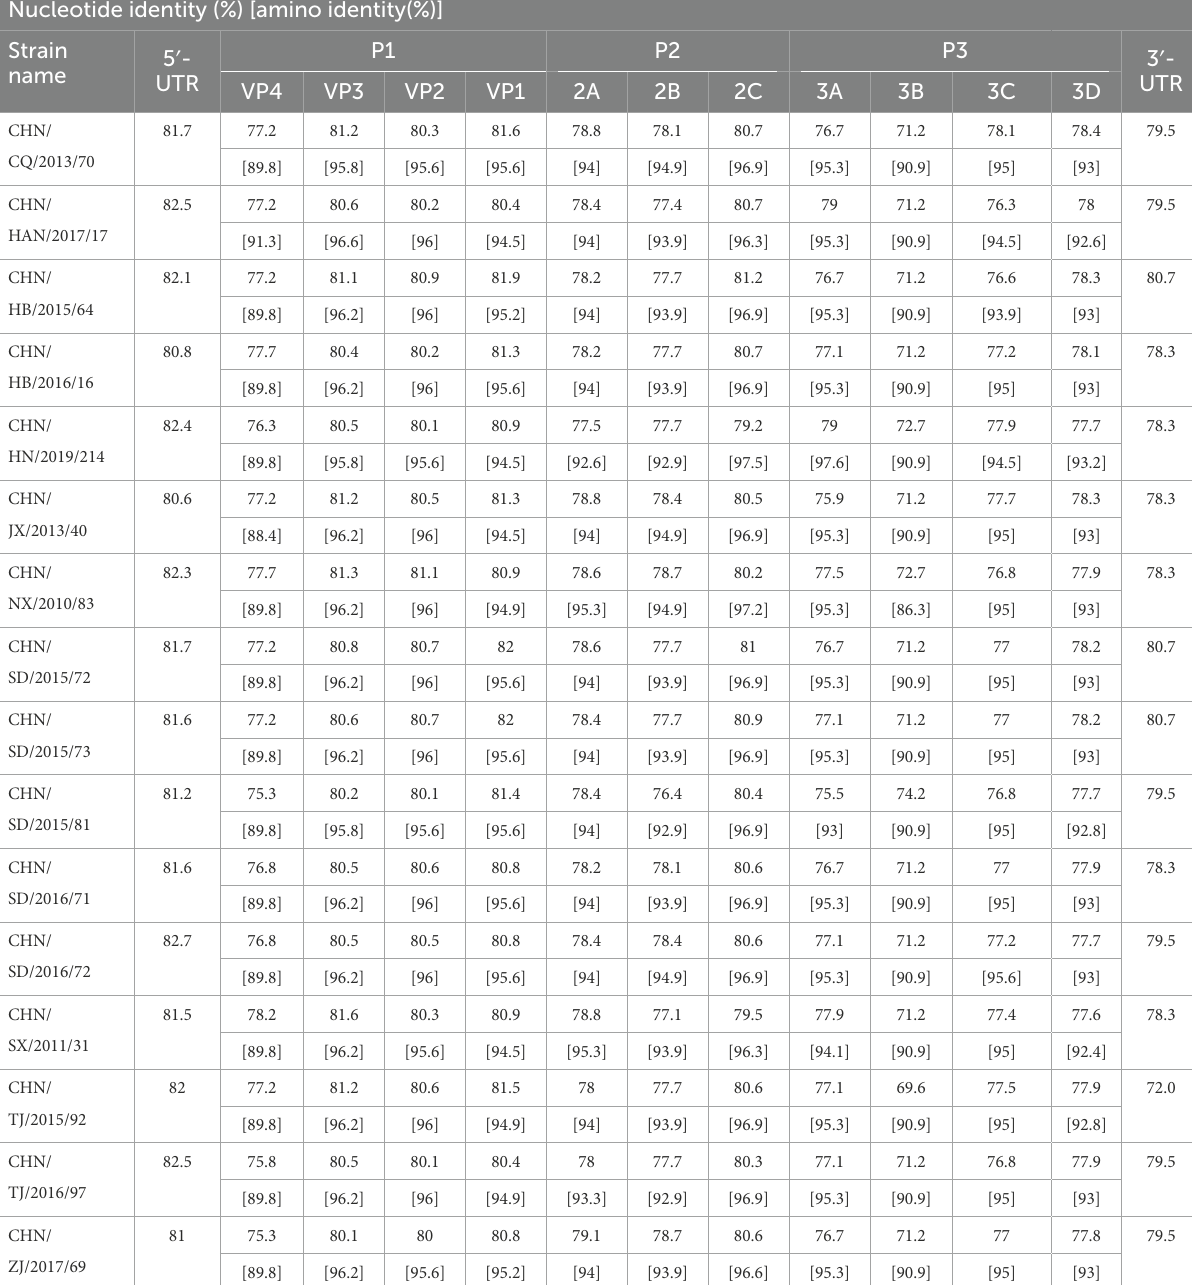
TABLE 2 Pairwise comparisons of nucleotide sequences and amino acid sequences among the 16 CVA12 strains and with the CVA12 prototype strain (AY421768.1/Texas-12). Nucleotide identity (%) [amino